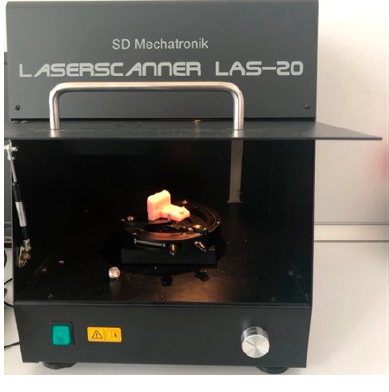
Figure 3. Laser scanner device